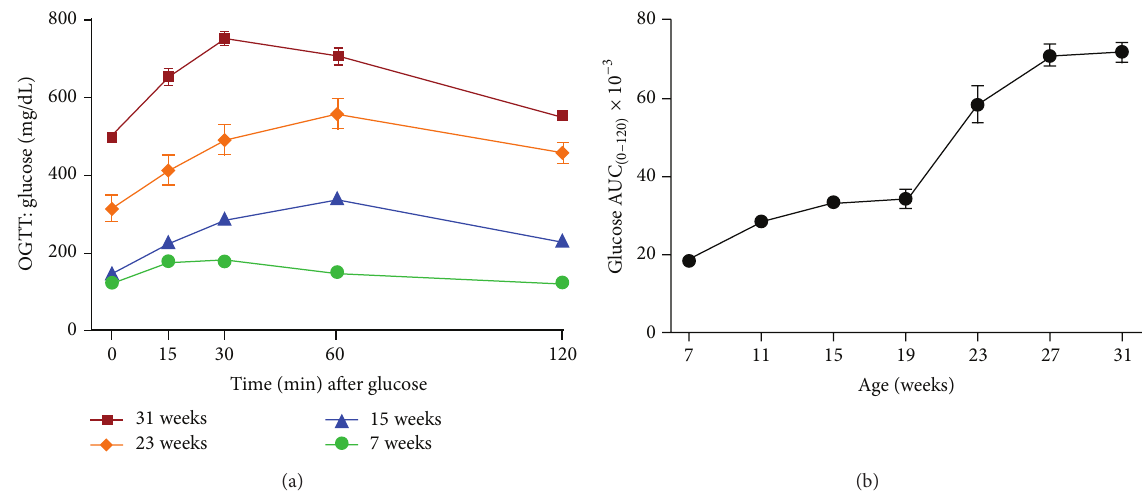
Figure 4: (a) Glucose levels from oral glucose tolerance tests in male ZDSD rats at 7 ( e ), 15 ( 󳵳 ), 23 ( X ), and 31 ( ◼ ) weeks of age and (b) glucose AUC calculations for all OGTTs (mean ± SEM, 𝑛 = 23 ).